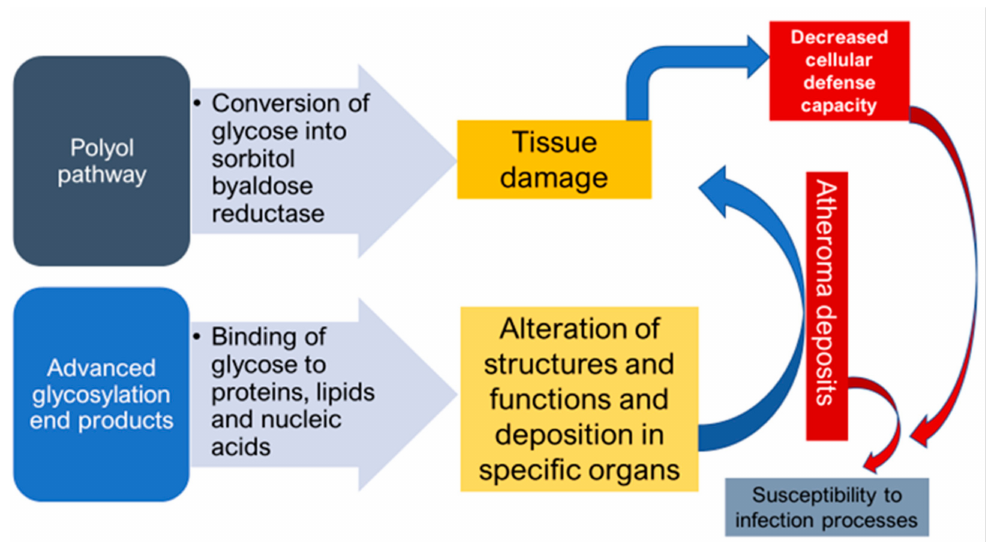
Figure 1. Mechanisms of formation of diabetic